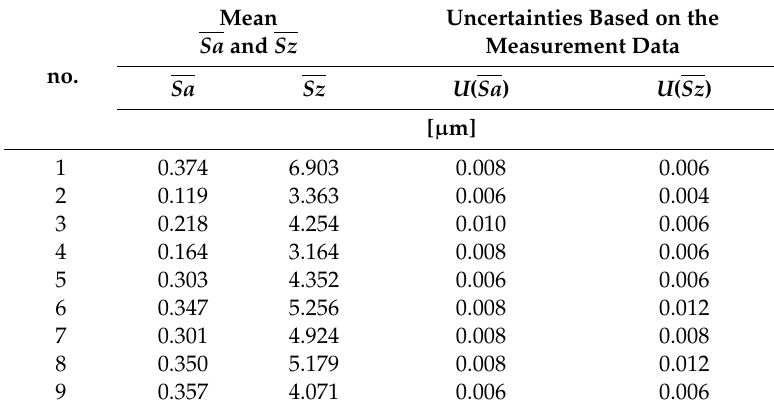
Table 3. Mean Sa and Sz and the associated